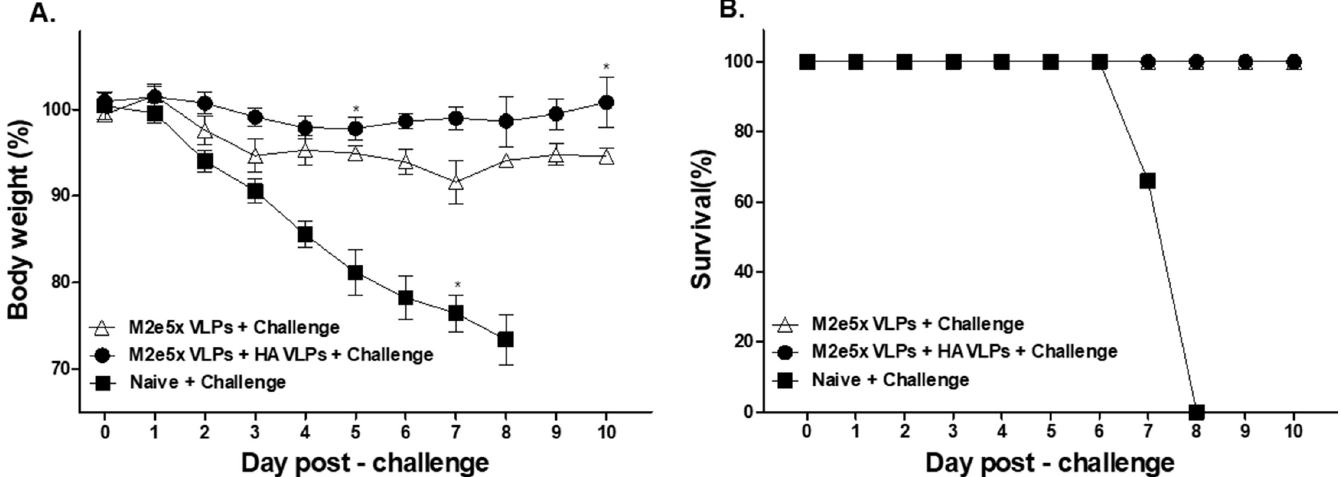
Fig 8. Protection efficacy of mice from lethal influenza virus challenge. Upon intramuscular immunization with VLPs and subsequent challenge infection with a lethal dose of A/Viet Nam/1203/2004 (rgH5N1) virus, mice body weight (A) and survival (B) were monitored daily for 10 days. Combinatorial VLPs showed significantly less body weight loss compared to combination M2e5x VLPs whereas all mice in Na ï ve + Challenge group reached endpoint. Data are expressed as mean ± SD, � P < 0.05.